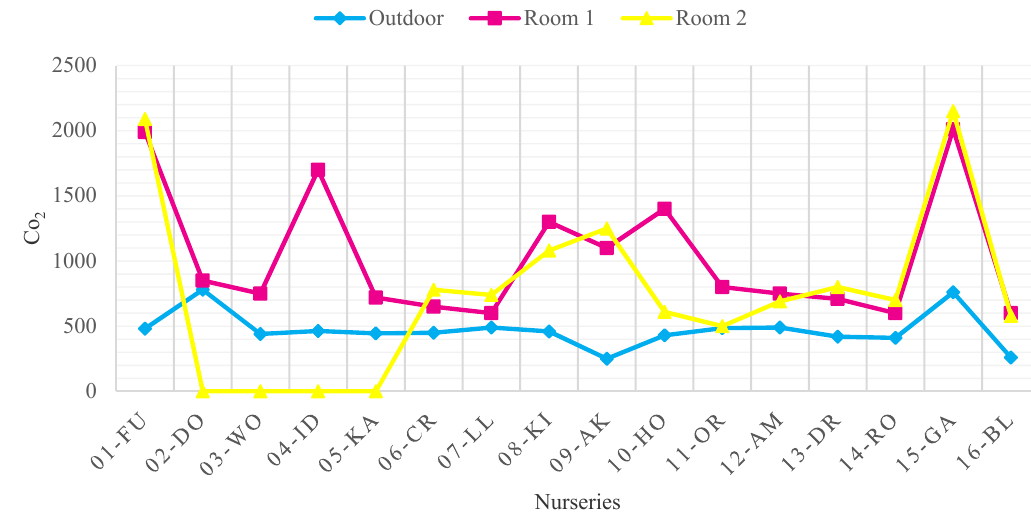
Figure 4. CO 2 concentration in each room and outside air before improvement (WHO Standard: 920 ppm).